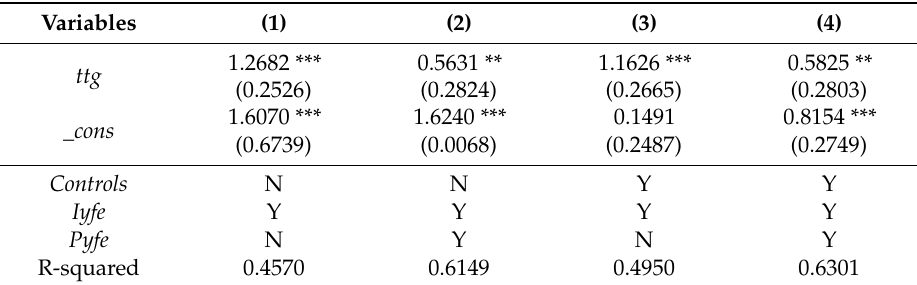
Table 3. Impact of ETS on carbon